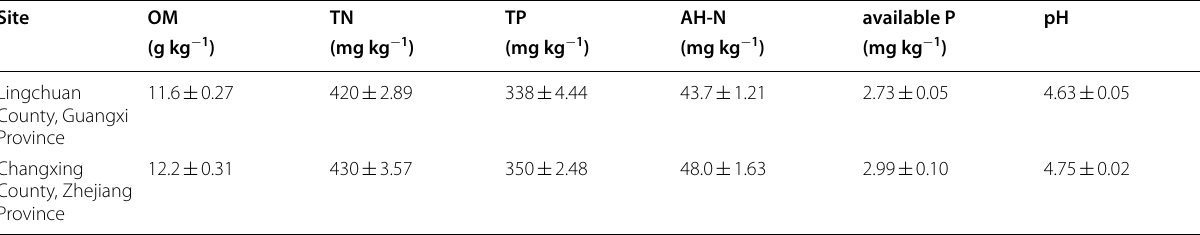
Table 5 Soil physical and chemical properties in seed provenance in Lingchuan County and the natural Moso bamboo forest in Changxing